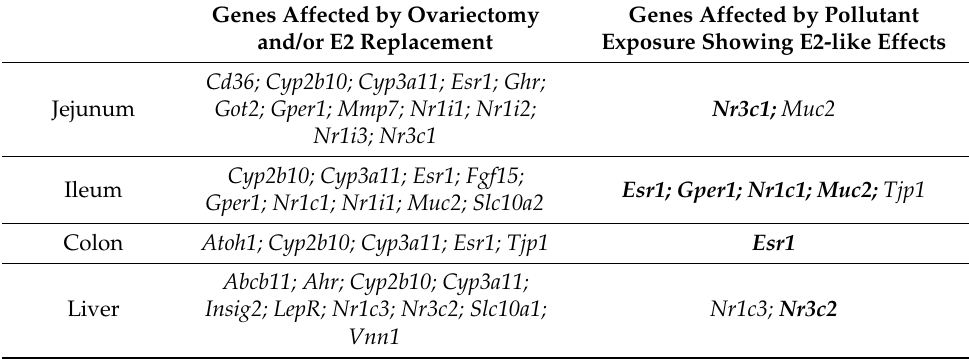
Table 1. Summary of the findings. List of genes in which the mRNA gene expression level is altered by ovariectomy and/or E2 replacement or following pollutant exposure. “E2-like effects” mean that the effects exerted by the mixture of pollutants mimicked the effects shown in the group “Ovx + E2 replacement”. In this case, the name of the genes is in bold type. Genes Affected by Ovariectomy Genes Affected by Pollutant and/or E2 Replacement Exposure Showing E2-like